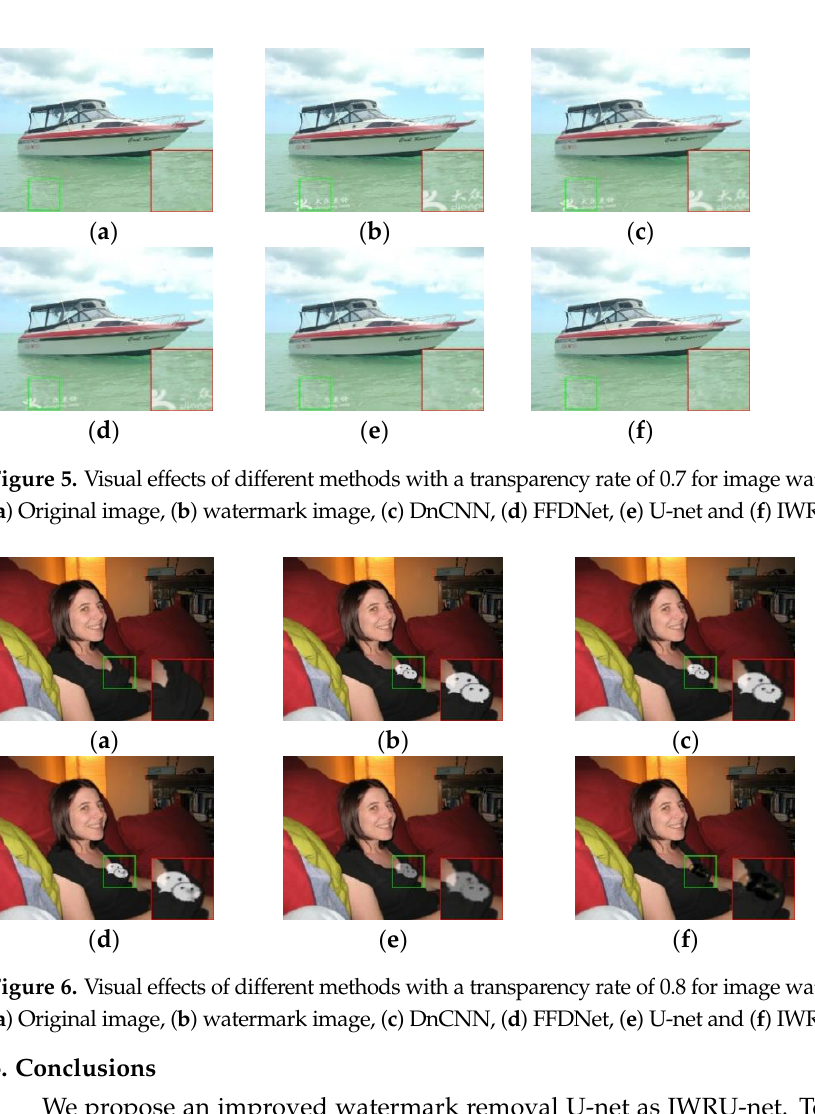
Figure 4. Visual effects of different methods with a transparency rate of 0.6 for image watermark removal. ( a ) Original image, ( b ) watermark image, ( c ) DnCNN, ( d ) FFDNet, ( e ) U-net and ( f ) IWRU- net (ours).